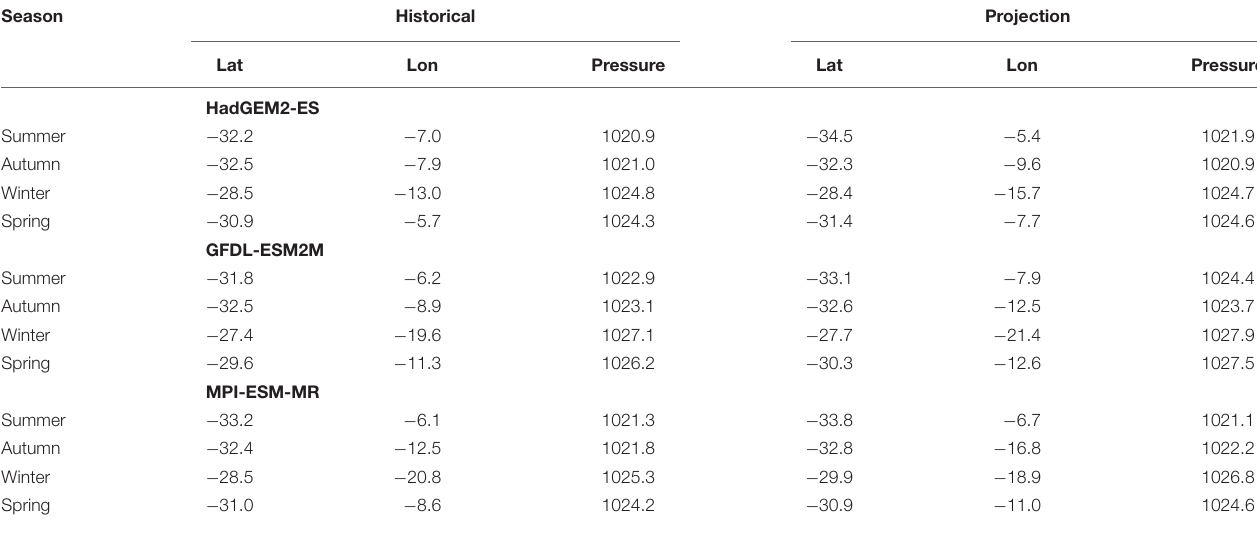
TABLE 2 | Seasonal climatology of the position of the highest SASA pressure center and its pressure (hPa) in the present (1979–2005) and future climate (2065–2095), considering the RCP8.5